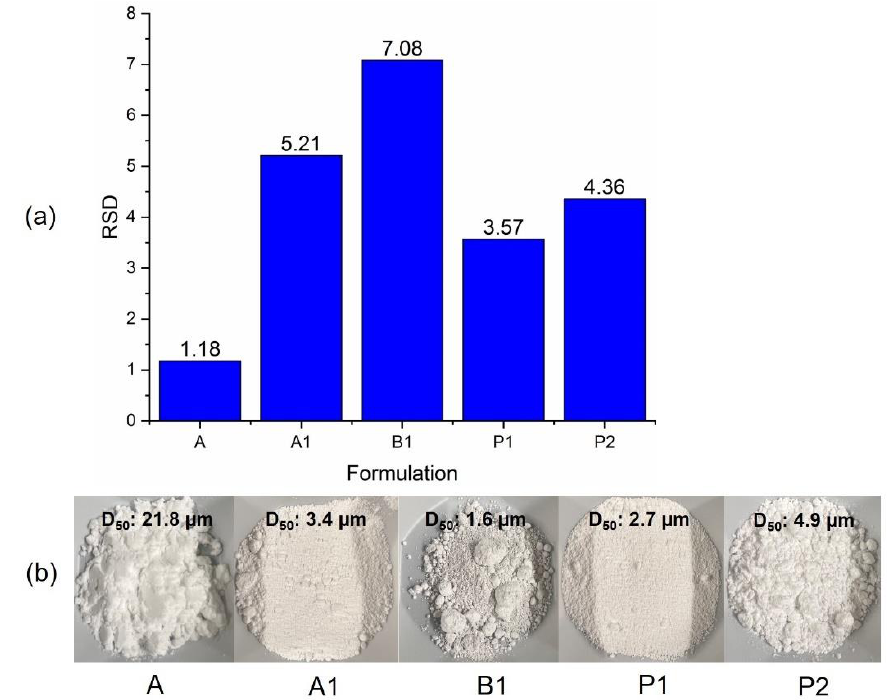
Figure 10. ( a ) Relative standard deviation of API loading of each formulation, which is an indicator of content uniformity ( n = 10); ( b ) bulk powders of 5 API batches used in the content uniformity